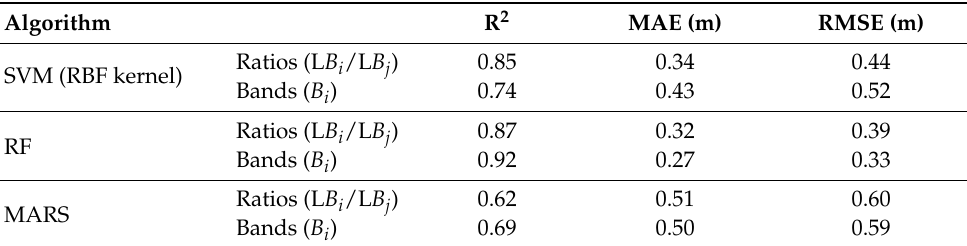
Table 2. Error statistics reported in meters for the SVM, RF and MARS algorithms and the Cand á s Port validation dataset.